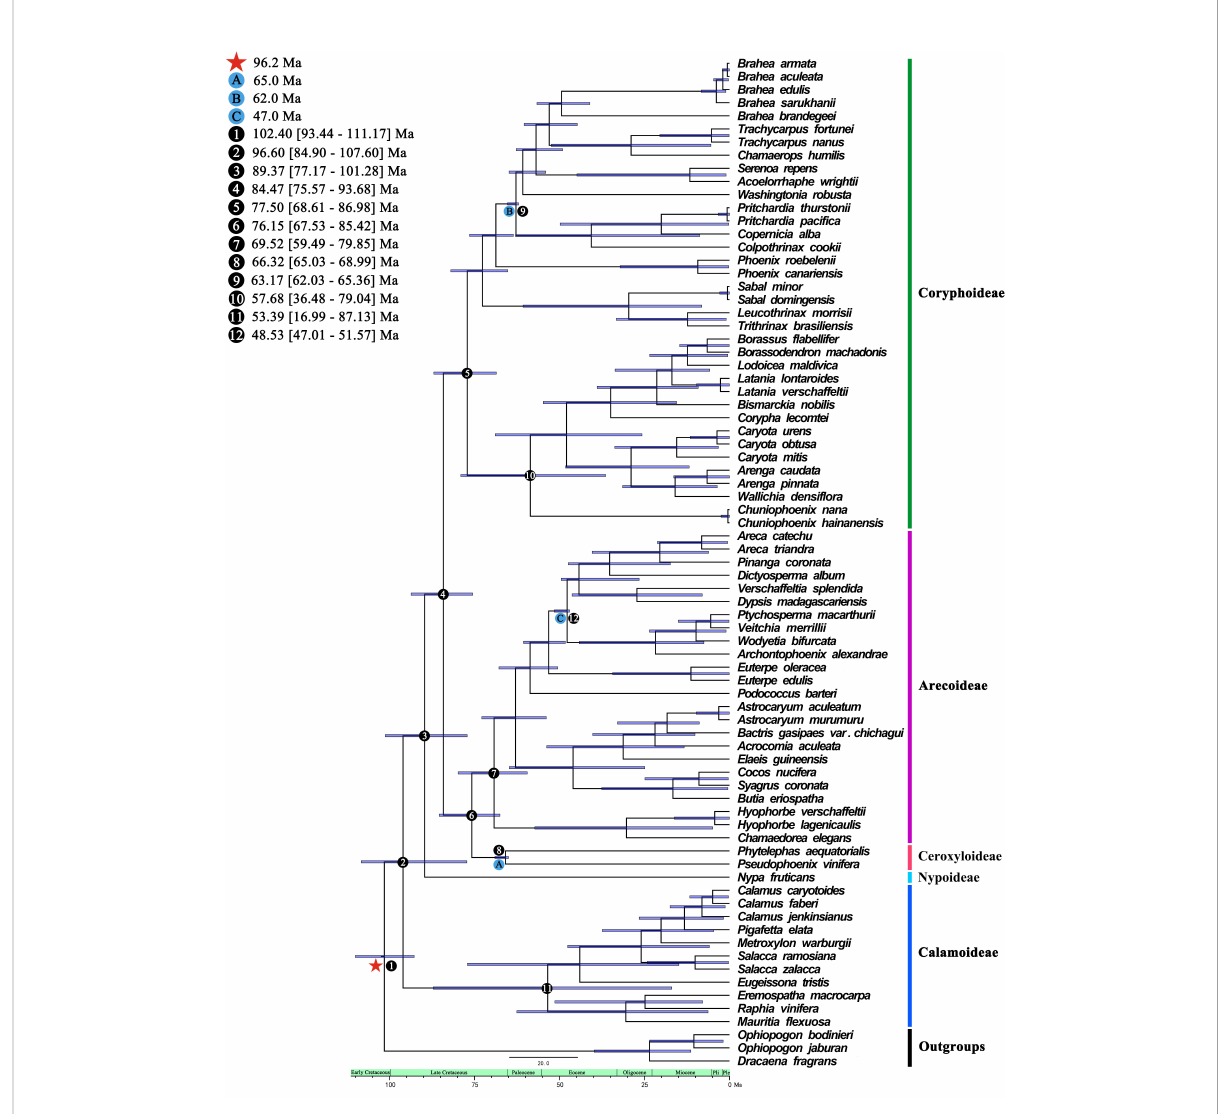
FIGURE 6 Species divergence times based on whole chloroplast genome datasets analyzed from BEAST. A, B, and C are calibration points, respectively, and star shape are secondary calibration points. Numbers 1-12 represent the estimated mean divergence times of the main divergence events and 95% highest posterior